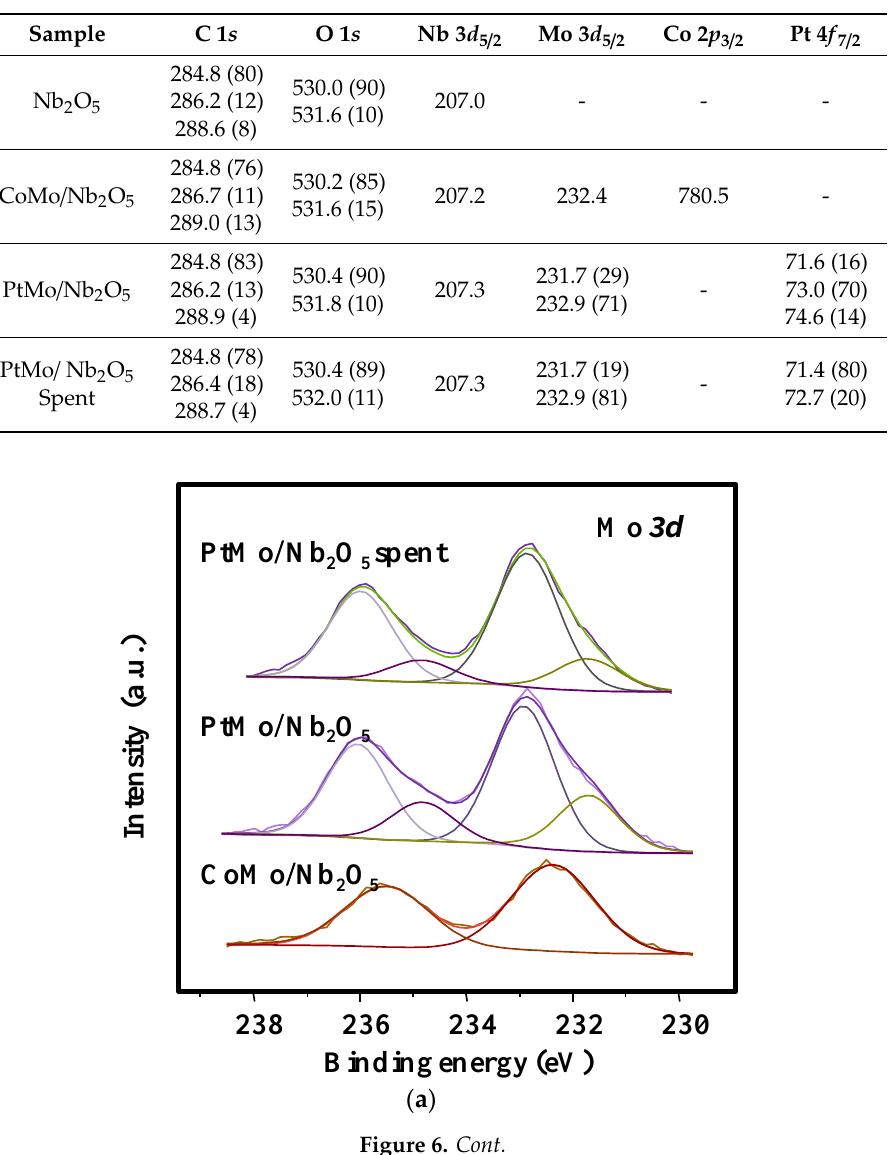
( b ) Figure 6. ( a ) Mo 3 d high resolution XPS spectra of fresh CoMo/Nb 2 O 5 and PtMo/Nb 2 O 5 samples and PtMo/Nb 2 O 5 spent catalyst. ( b ) Pt 4 f spectra of both fresh and spent PtMo/Nb 2 O 5 catalysts. The Pt 4 f core level spectra of PtMo/Nb 2 O 5 sample is shown in Figure 6b. The deconvolution of the spectra reveals three doublets at low BE for Pt 4 f 7/2 peak at 71.4 eV (16%), 73.0 (70%), and 74.7 eV (14%). A peak overlapping with the peak at 74.7 eV along with two peaks at 76.1 and 77.4 eV can be found for Pt 4 f 5/2 (Figure 6b). According to the findings, the BE at 73.0 and 74.7 eV are due to Pt 2+ from PtO x species, whereas the contribution at 74.7 and 77.4 eV are assigned to the presence of Pt 4+ species [33,34]. The minor contribution at 71.4 eV is associated with the Pt° [33], although this specie is not probable in the fresh catalyst. Moreover, the Mo/Nb ratio for PtMo/Nb 2 O 5 sample is 0.254, being higher than that of CoMo/Nb 2 O 5 indicating that Mo particles are mostly exposed on surface of the PtMo/Nb 2 O 5 catalyst .